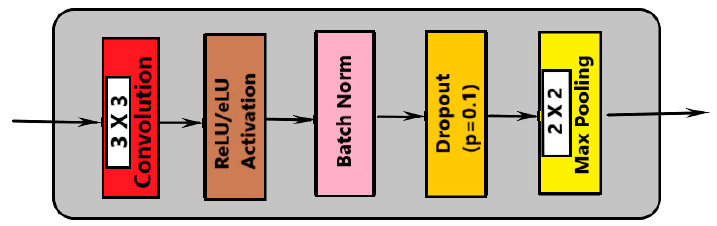
Figure 5. Operations in each layer of the contraction path.